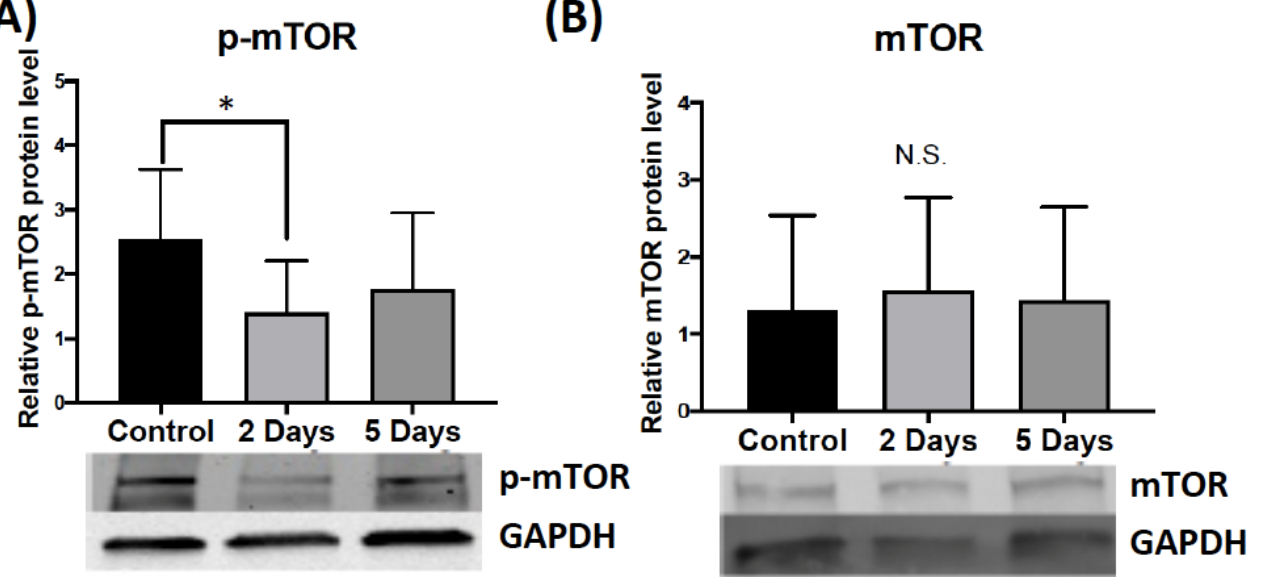
Figure 3. The effect of aggressive interactions on the phosphorylation and the expression of intra- cellular signaling molecules that regulate FMRP in the medial prefrontal cortex (mPFC). ( A ) There was a decrease in the phosphorylation of mammalian target of rapamycin (mTOR) (phosphorylates S6K) in the mPFC 10 min following 2 consecutive days of aggressive interactions compared to female Syrian hamsters that had no social interaction experience (* p < 0.05). ( B ) There was no change in the overall protein expression of mTOR in the mPFC 10 min following 2 consecutive days of aggressive interactions compared to female Syrian hamsters that had no social interaction experience (N.S.). (Control n = 7–8, 2 Days n = 9–11, 5 Days n = 8–11). Data are presented as mean +/ − standard deviation.